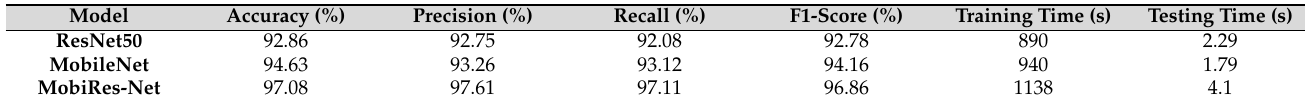
Table 3. Average classification results of the original